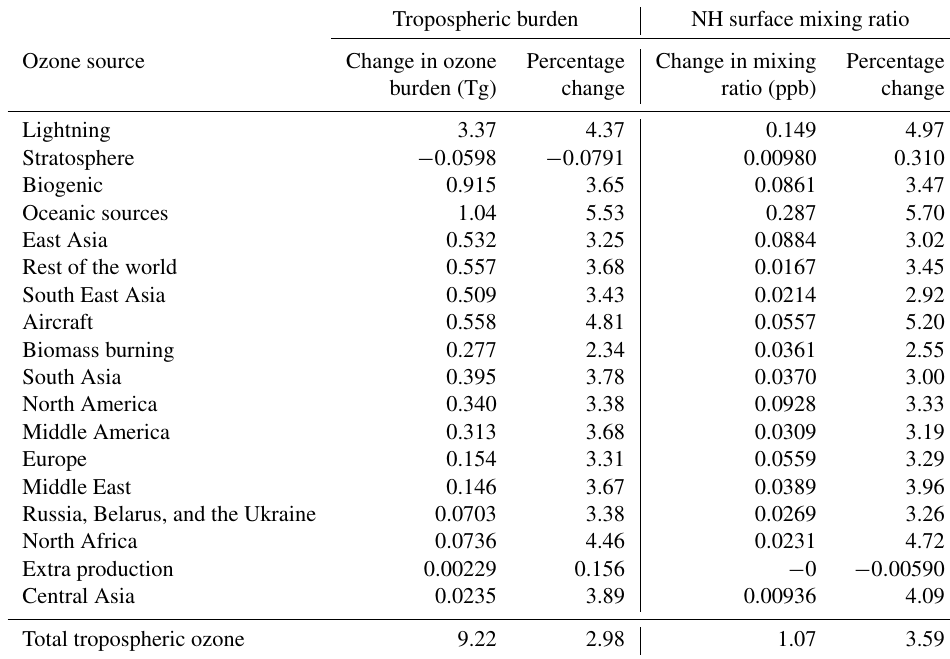
Table 5. Change in the contribution of NO x sources to tropospheric and Northern Hemisphere surface ozone in response to a 25% increase in the imposed surface mixing ratio of methane. Absolute changes and percentage changes are both